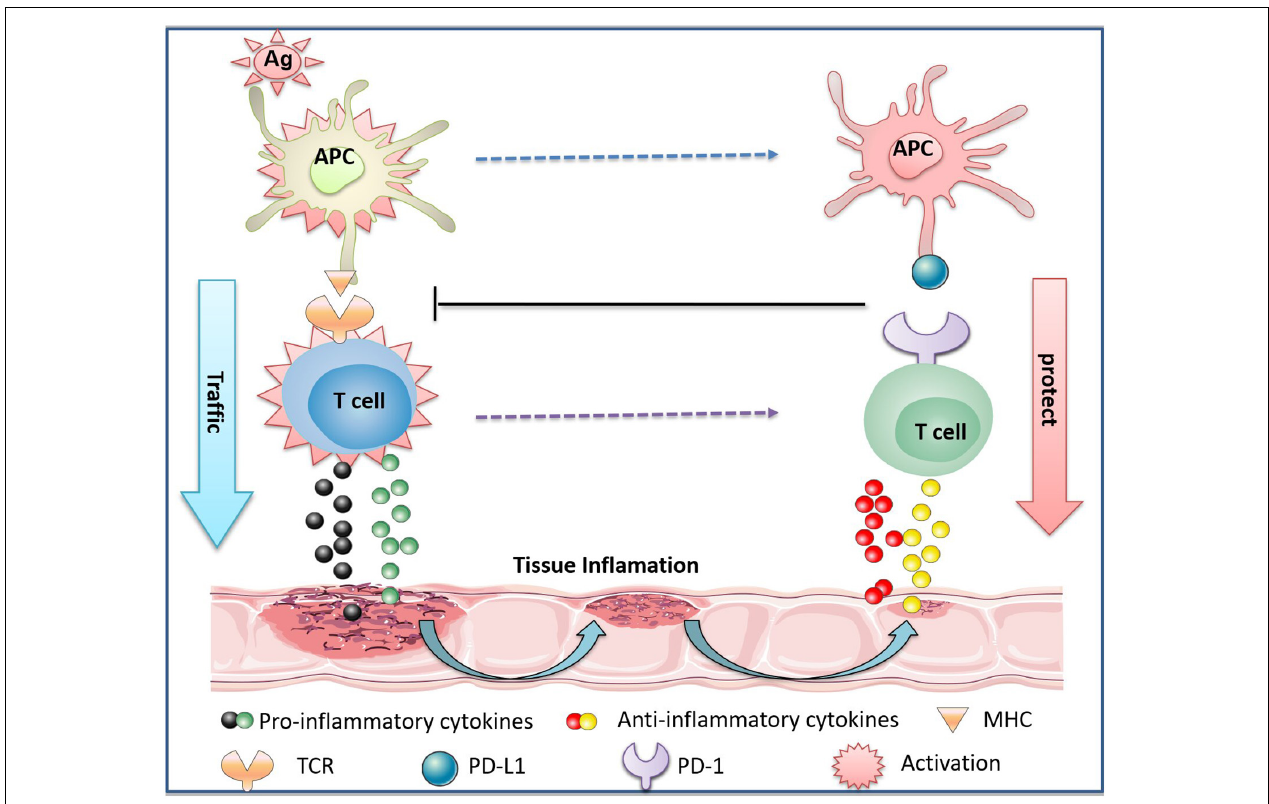
FIGURE 2 | The protective effect of PD-1/PD-L1 on immune inflammatory tissues through T cells. The antigen (Ag) invades the body to activate APC. It is captured by major histocompatibility complex (MHC) molecules on APC, which binds to TCR on T cells to activate T cells. Activated T cells release pro-inflammatory cytokines, causing tissue damage. In parallel, activated APC and T cells express PD-L1 and PD-1, respectively, and the interaction of PD-L1 and PD-1 promotes the release of anti-inflammatory cytokines by T cells. The binding of PD-L1 to PD-1 also inhibits the activation of APC and T cells, thereby reducing tissue inflammation, promoting tissue repair, and protecting normal tissues from immune inflammatory response-induced